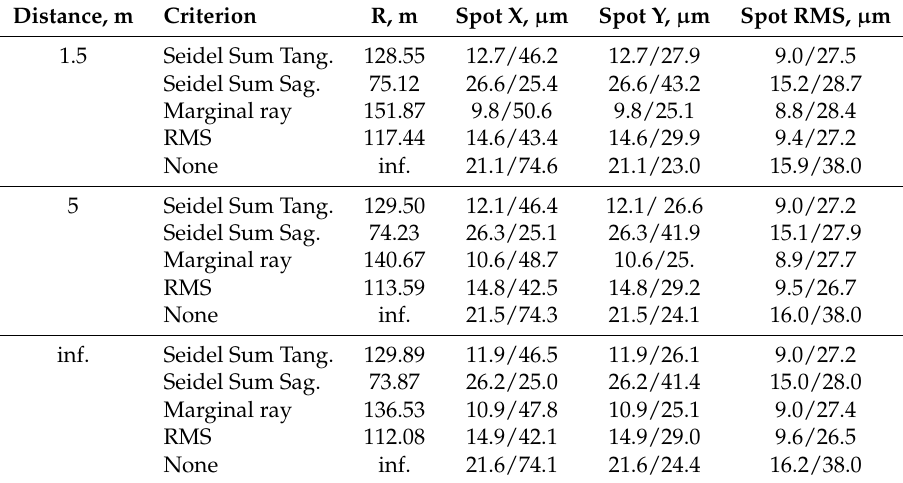
Table 1. Field curvature computations for demonstrative example (FoV center/corner). Distance,